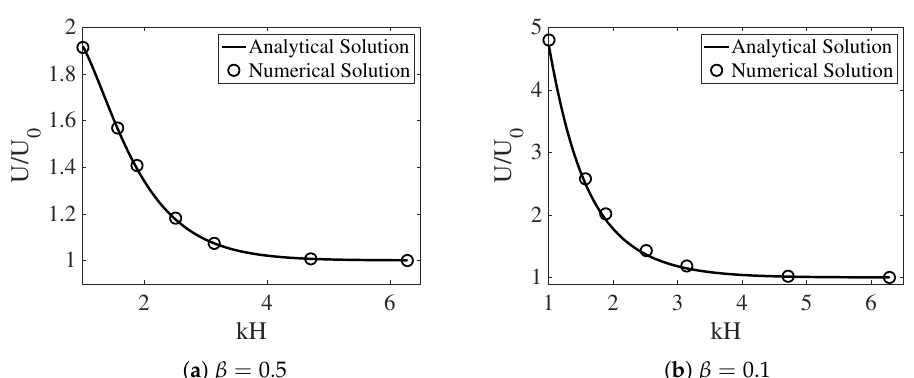
Figure 7. The scaled swimming speed vs. the nondimensional interface height kH for different β . The fluid interfaces are deformable. The analytical solutions are from [11].